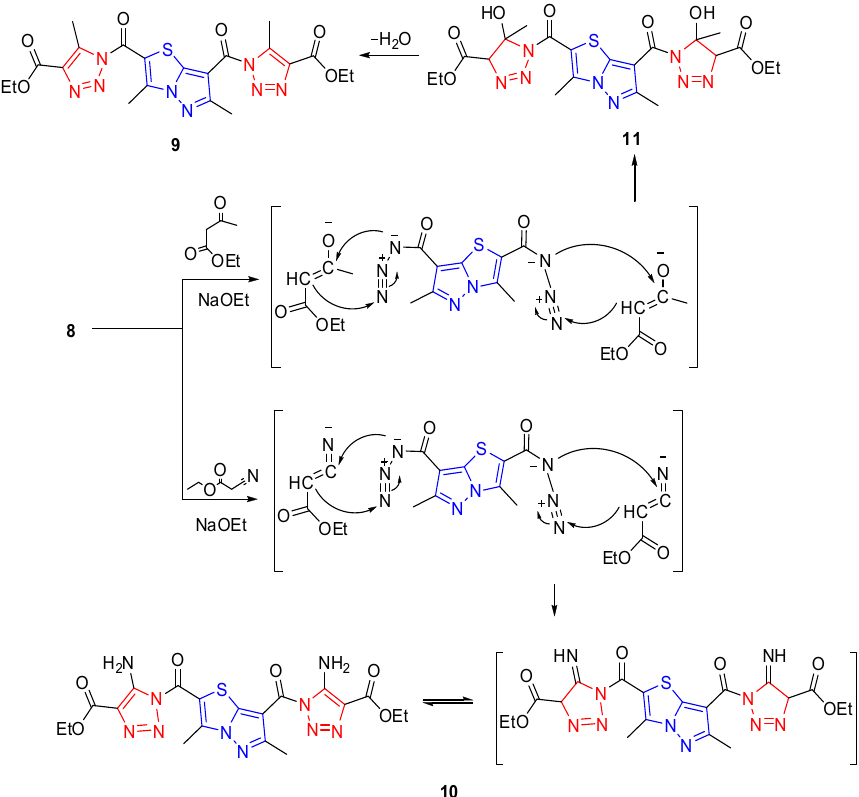
Scheme 5. A suggested reaction mechanism for the synthesis of triazoles 9 and 10 .